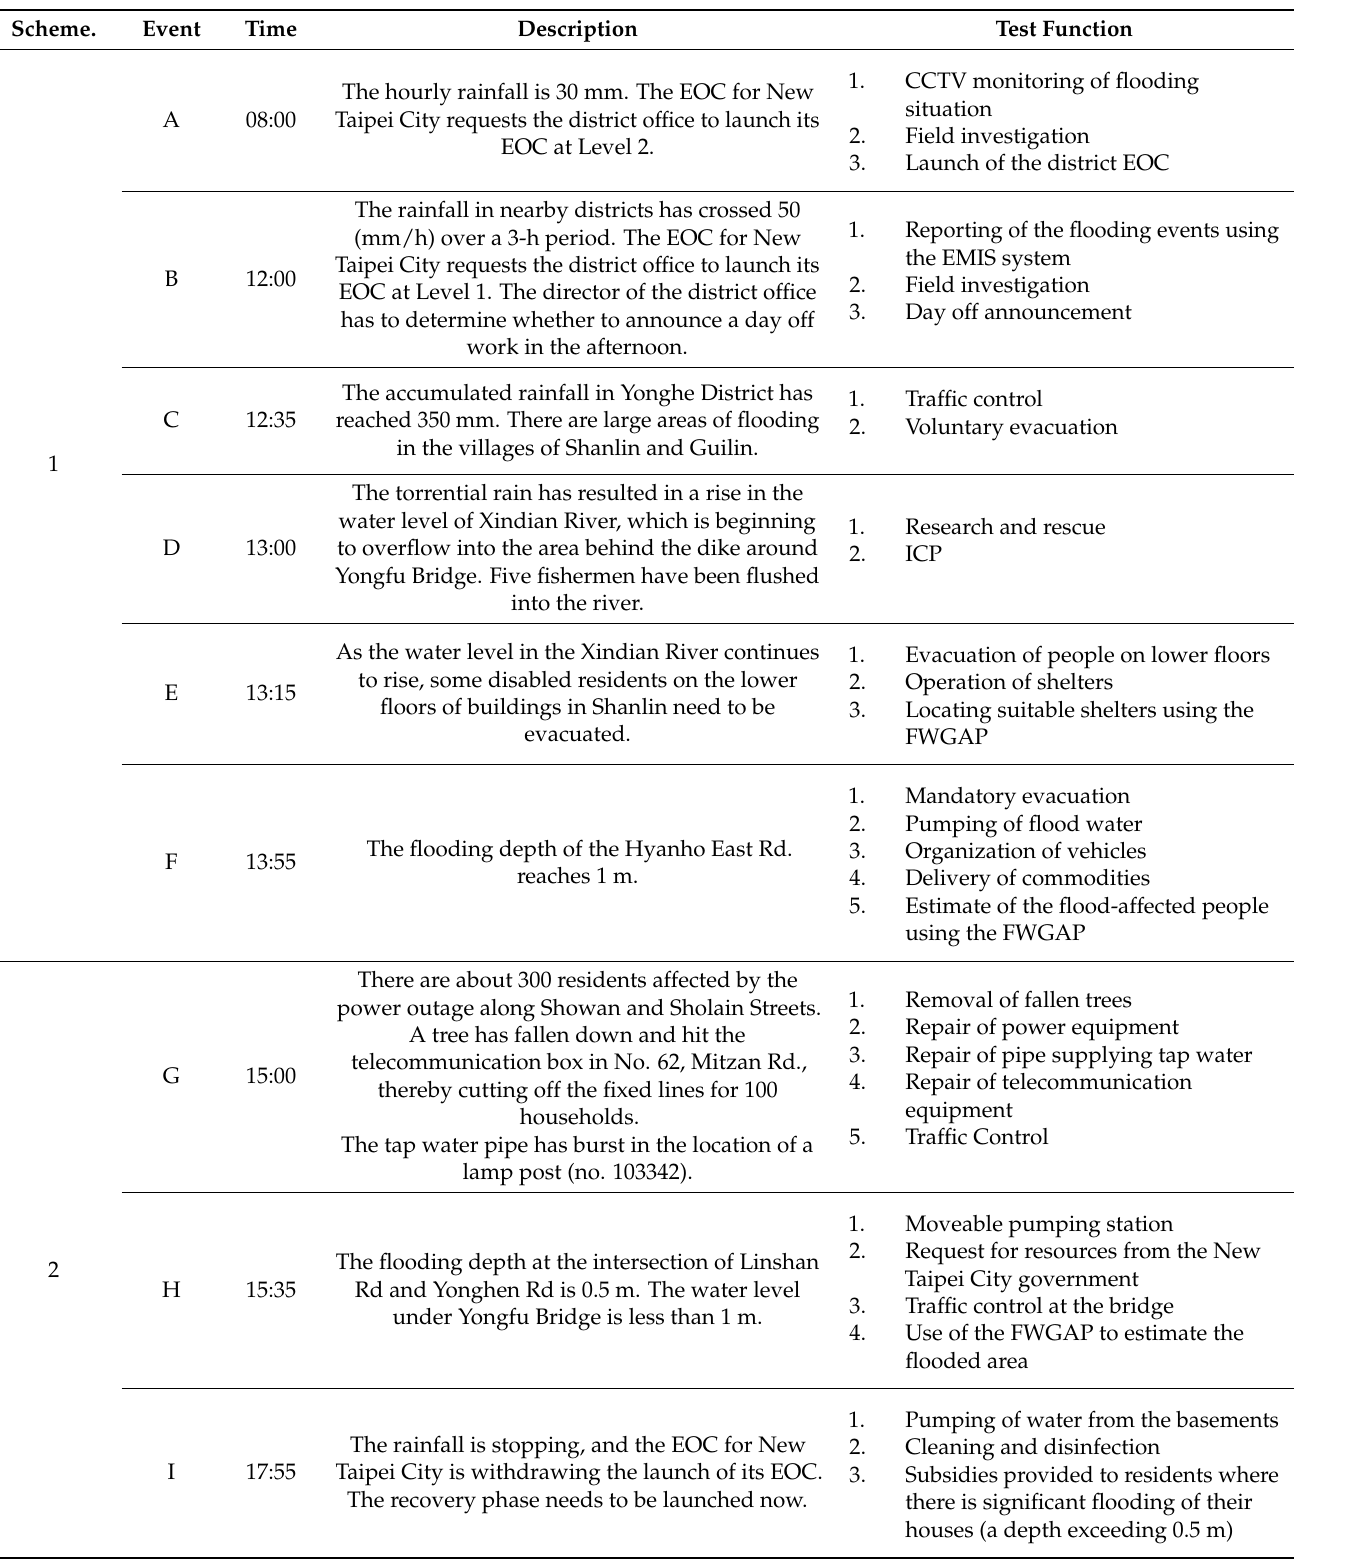
Table 3. Main events and test functions of the flooding wargame implemented for Yonghe District.